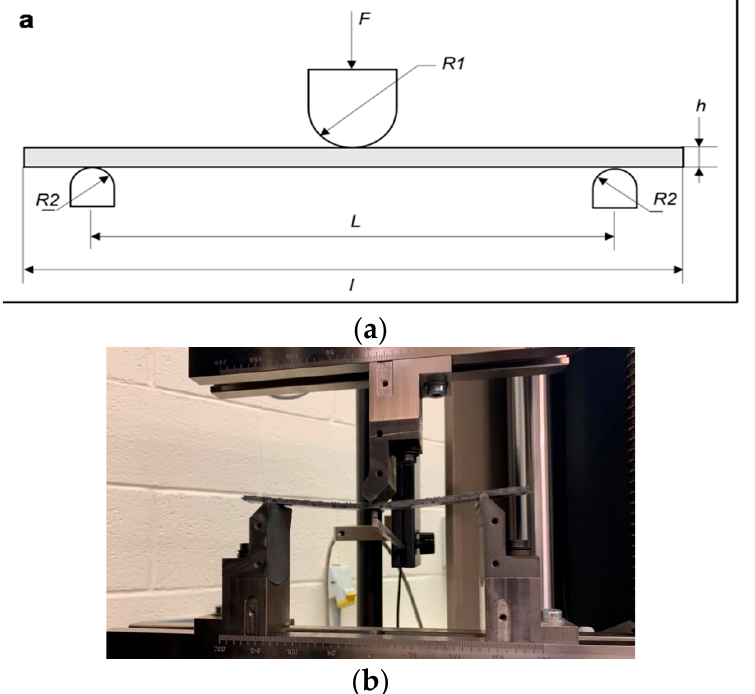
Figure 8. ( a ) 2D sketch of 3-point flexural test, ( b ) Physical 3-point flexural illustration according to BS-ISO 14125:1998 . Support span 20h mm (class III) and 40h mm (class IV). The maximum flexural stress ( σ f ), flexural modulus ( E f ) and strain ( ε ) were calculated using Equations (1)–(3).